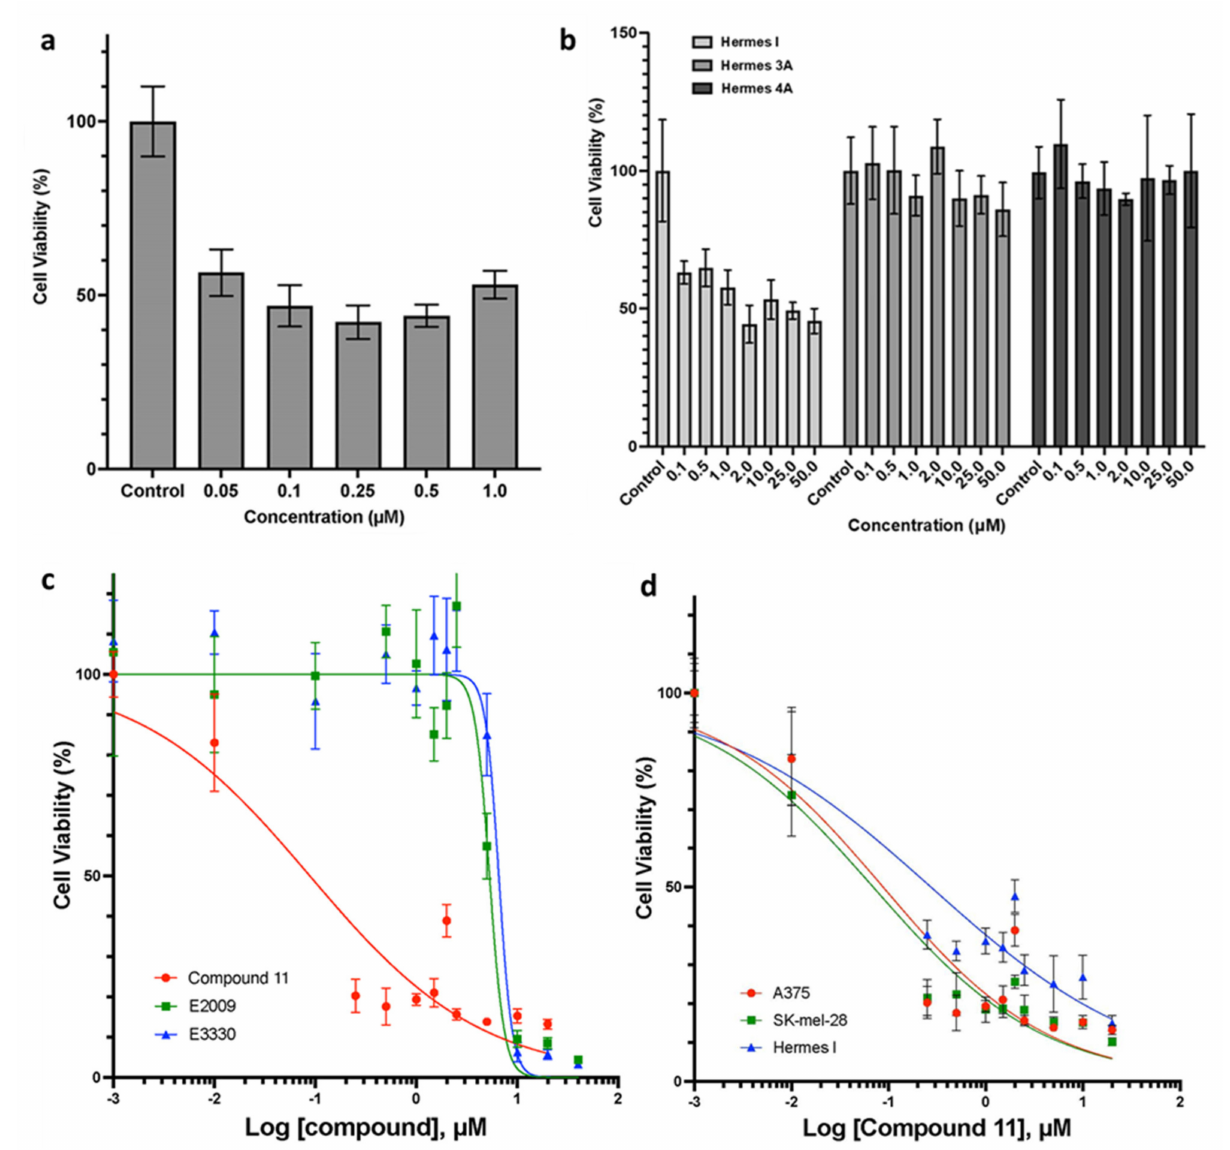
Figure 3. Potent cytotoxicity of compounds 2 and 11 in human melanoma cells. Cell viability was determined by MTT assay. The results are shown as the percentage of viable cells after 72 h treatment at different concentrations. The results were statistically processed from three independent experiments. The IC 50 was calculated using GraphPad Prism 8. ( a ) Cytotoxicity of compound 2 in A375 melanoma cells; ( b ) Cytotoxicity of compound 2 in human immortalized melanoblasts cells (Hermes 1, 3A, and 4A). The bars represent the average of three independent experiments. Hermes